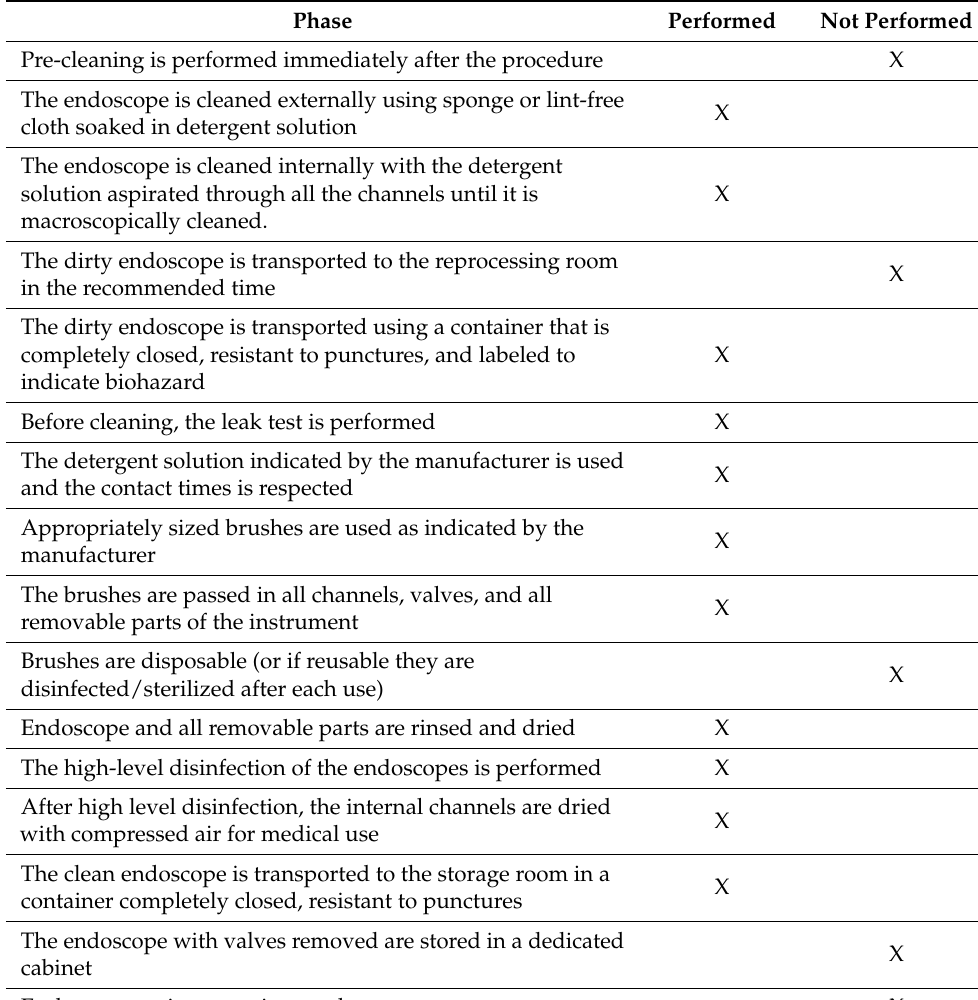
Table 1. Checklist of the reprocessing process and critical issue observed before the remedial actions. Phase Performed Not